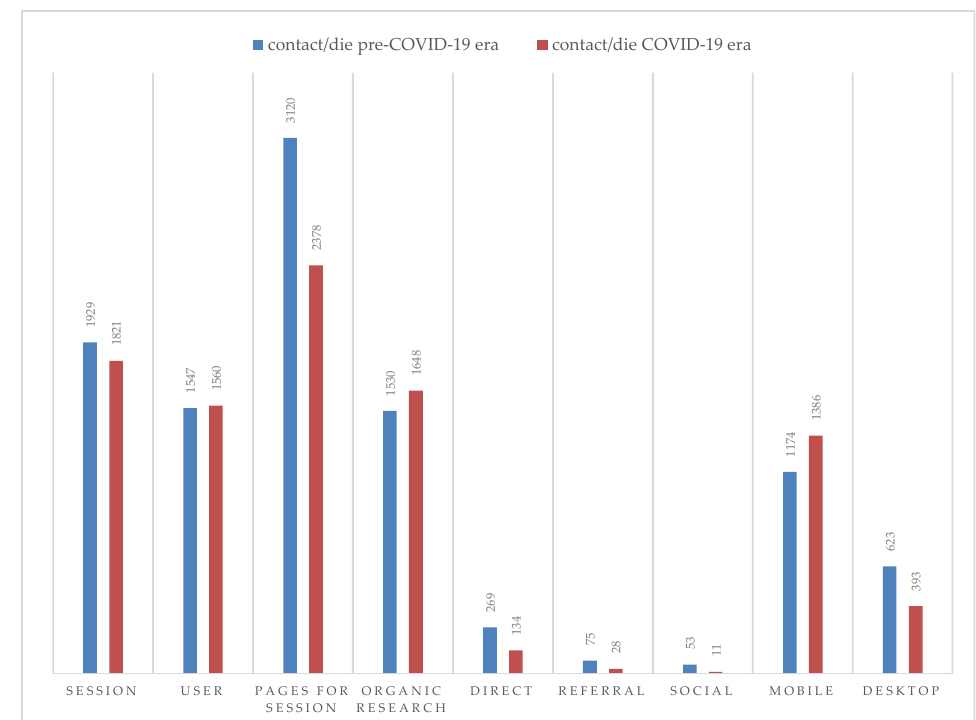
Figure 1. Metrics recorded by the VaccinarSì website per single day during pre-COVID-19 era vs. COVID-19 era.